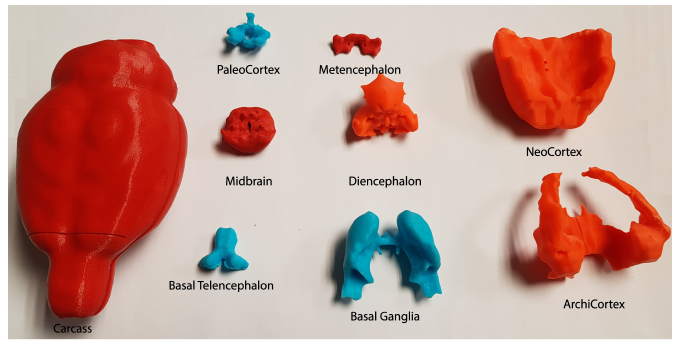
Figure 6. Final 3D model (disassembled) of the rat template.